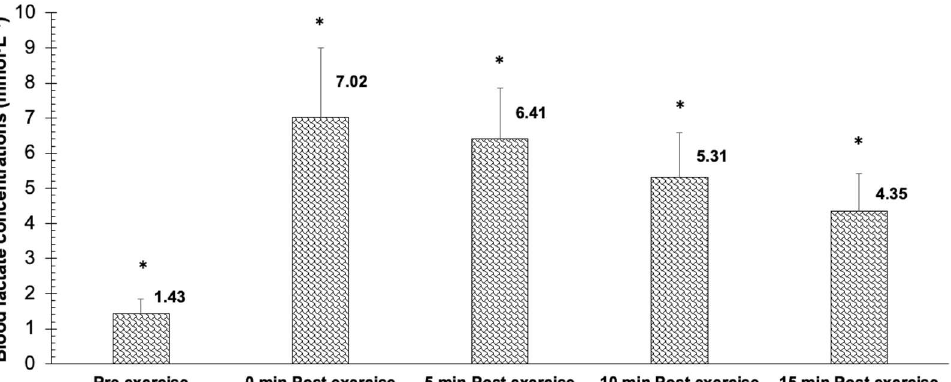
Figure 5. Blood lactate concentrations before and the BP exercise protocol and at minute 0, 5, 10 and 15 after the exercise. * = significant difference between all sets ( p < 0.05).